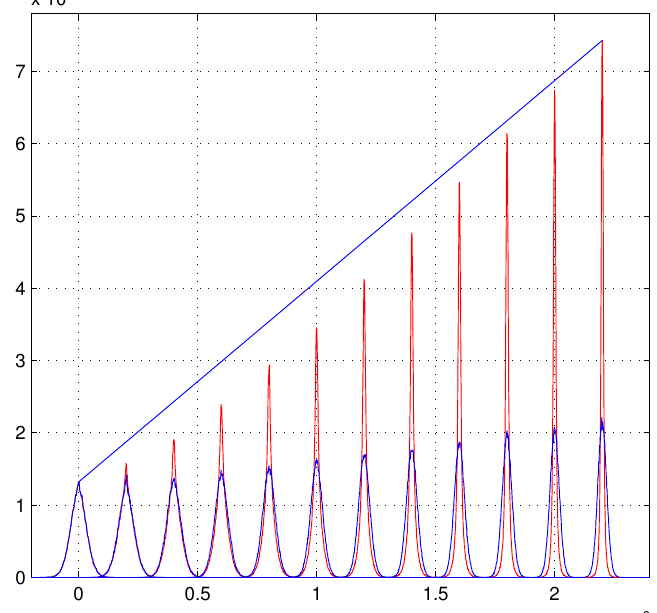
Figure 2. Another Gaussian model. A faster increase in the maximums compared to that of Figure 1. The blue straight lines connect the maximum of the first distribution to that of the last red distribution. The color cade is that of Figure